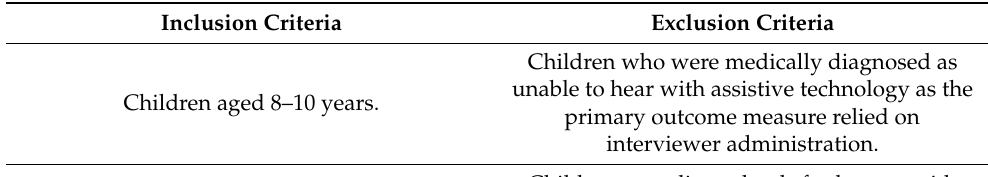
Table 1. Inclusion and exclusion